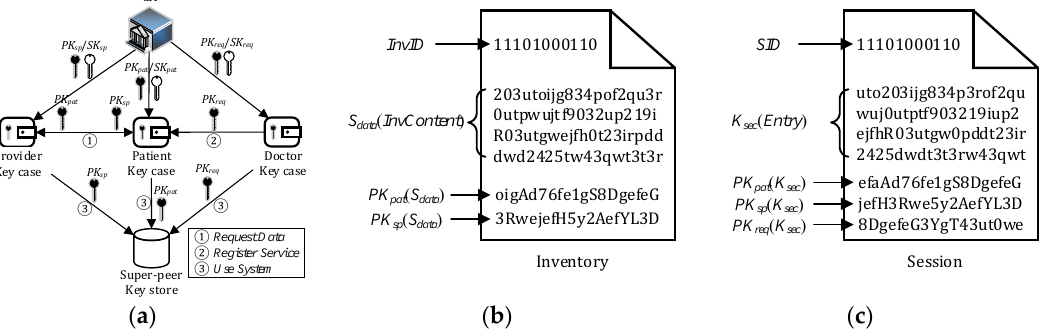
Figure 7. Key Management Scheme: Keys are stored in ( a ) key case, ( b ) inventory, and ( c ) session through encryption.